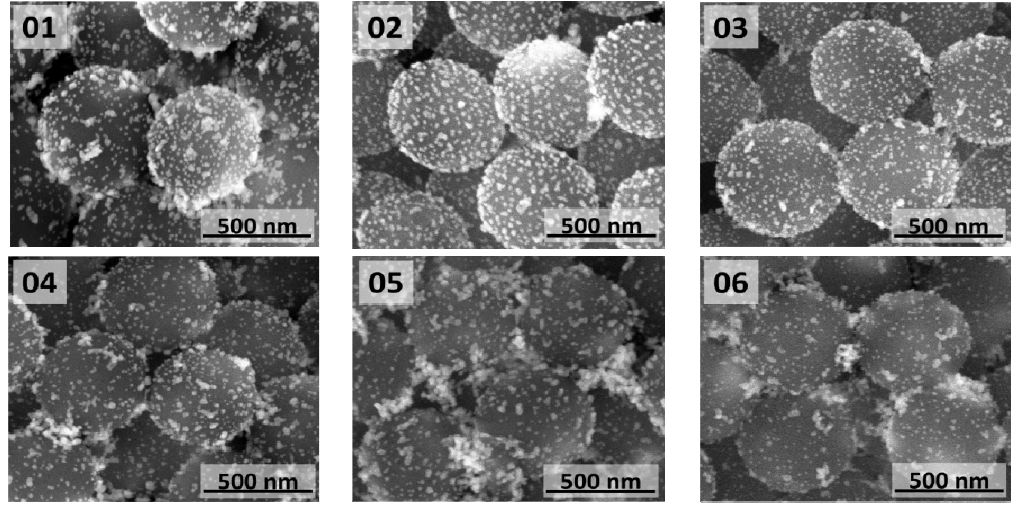
Figure 4. SEM images of SiO 2 @Au nanostructures obtained by direct reduction of gold salts on functionalized SiO 2 particles at various temperatures: ( 01 ) 100 °C; ( 02 ) 90 °C; ( 03 ) 80 °C; ( 04 ) 70 °C; ( 05 ) 60 °C; and ( 06 ) 50